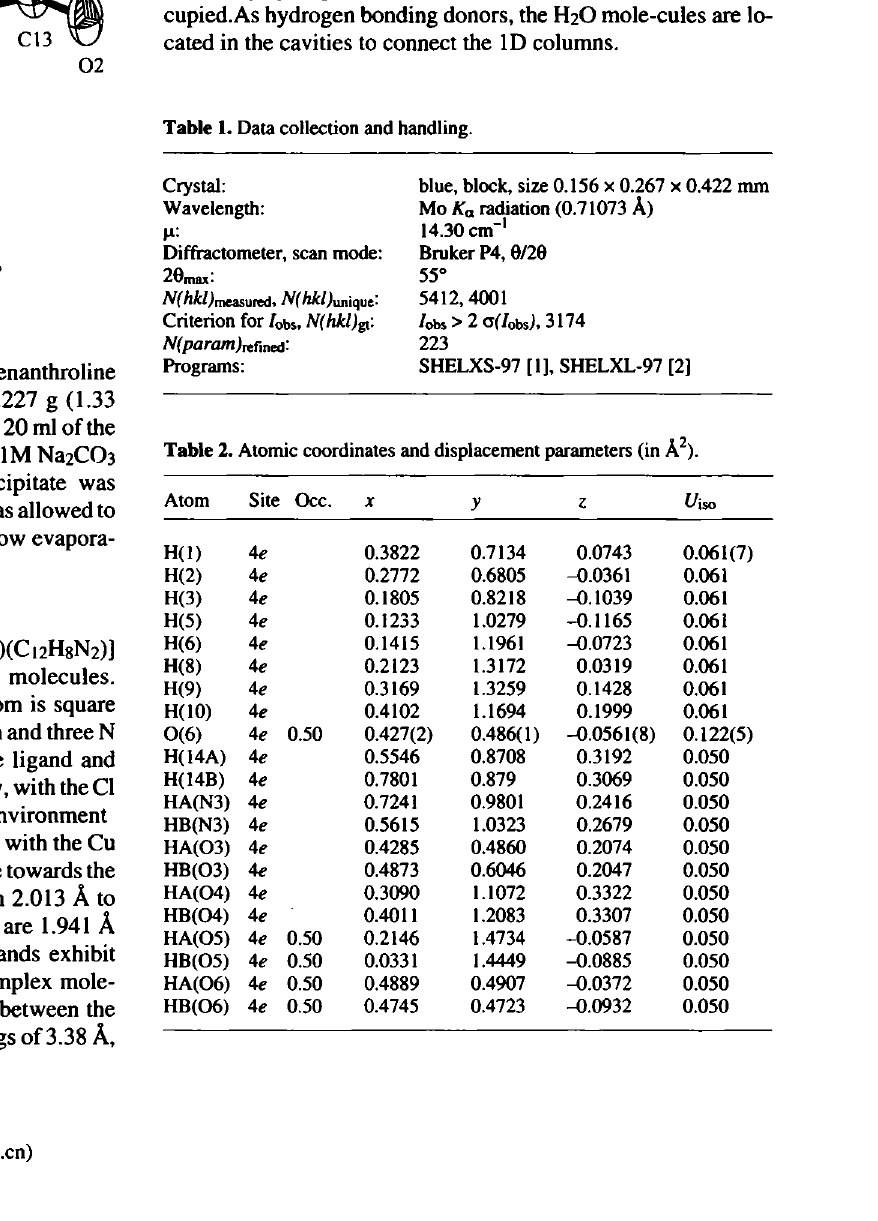
Table 1. Data collection and handling.